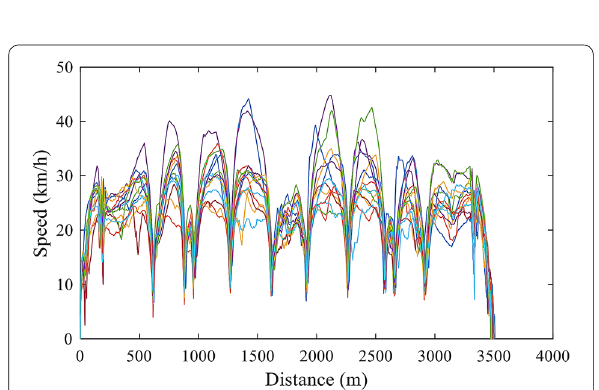
Figure 3 Fixed route driving speed-distance